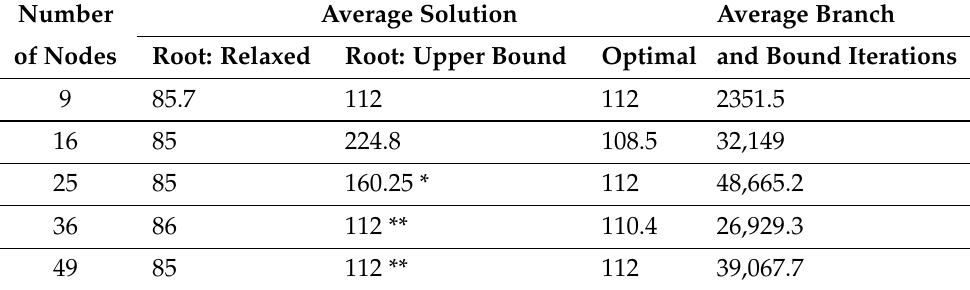
Table 9. Comparison of average relaxed solution and upper bounds in the root node for algorithm using maximal energy consumption index. The optimal solution is found after the number of branch and bound iterations presented in the last column. Value marked with (*) and (**) are means of 5 of 6 cases and 2 of 9 cases, respectively as CPLEX did not provide an initial approximation in the root node for all tasks.